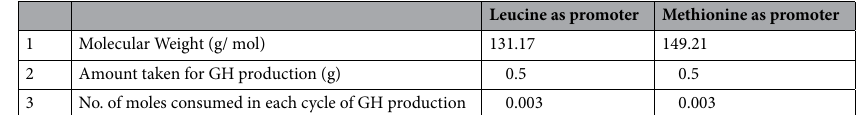
Table 1. Number of moles consumed for leucine and methionine in production of